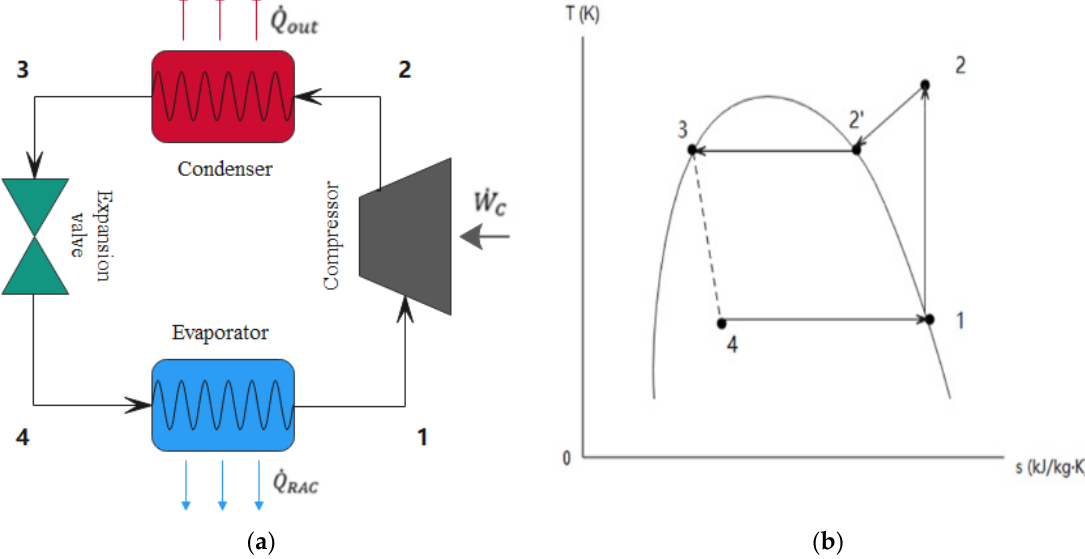
Figure 4. ( a ) Vapor compression RAC system; ( b ) Baseline cycle (Cycle 1) in T-s diagram (1 → 2 → 3 → 4 →